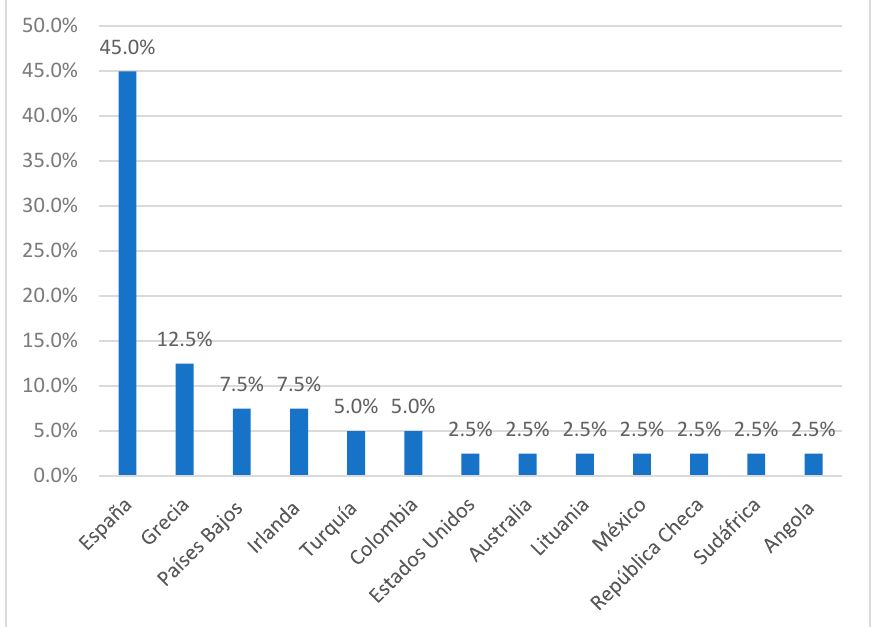
Source: own production.